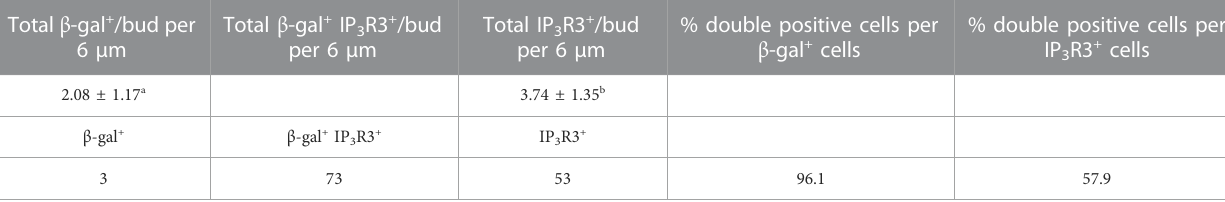
TABLE 1 Number of β -gal-positive cells and IP 3 R3-positive Type II cells in adult bud. Total β -gal + /bud